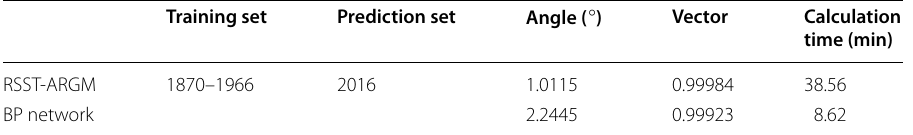
Table 2 Comparison of the prediction effects of the two